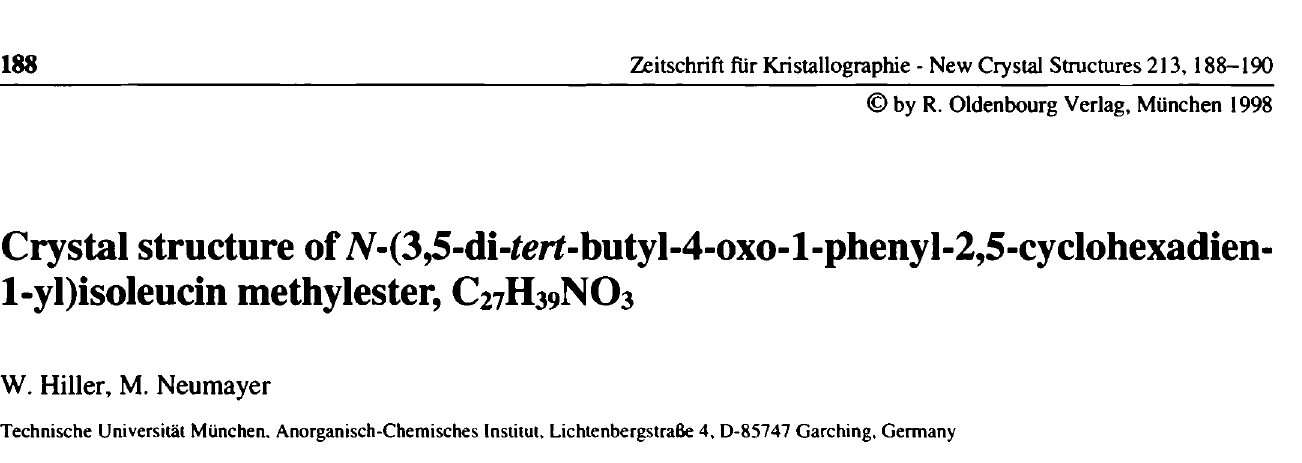
Table 2. Final atomic coordinates and displacement parameters (in Â~)